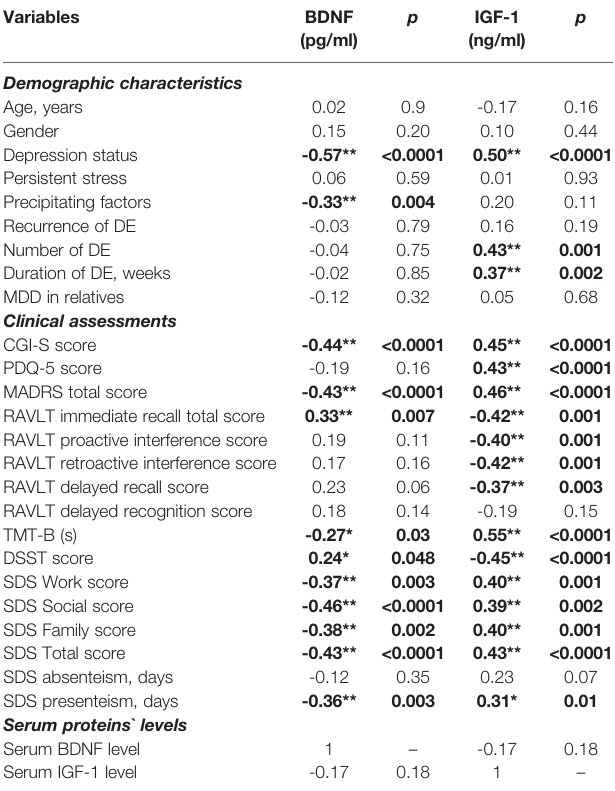
TABLE 2 | Spearman ’ s/Pearson ’ s correlations between demographic, psychopathological, neuropsychological characteristics, and serum BDNF and IGF-1 levels in MDD patients and healthy controls.